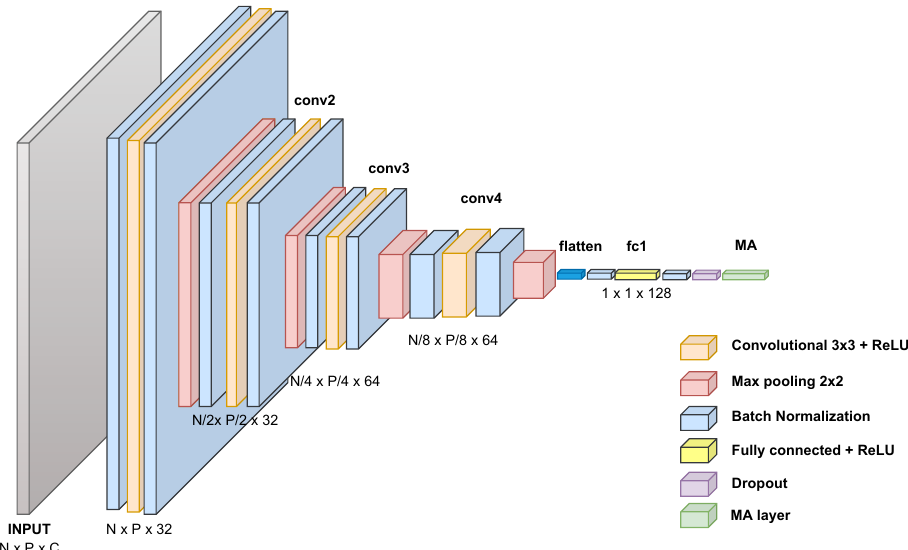
Figure 3. GCECDL-based convolutional architecture for image databases. Four convolutional layers with 3 × 3 patches, 2 × 2 max pooling, and ReLU activations are included. The MA layer outputs the hidden ground truth label and the annotator’s reliability fixing a softmax and a sigmoid activation,